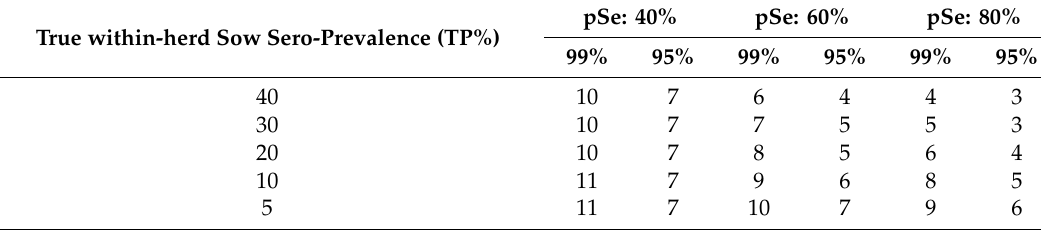
Table 4. Number of pools required ( r ) for fixed pool size ( k = 3) to provide 99% or 95% confidence to detect decreasing values of true within-herd sow prevalence (TP) assuming a pool sensitivity (pSe) of 40%, 60% and 80% and a pool specificity of 65%. True within-herd Sow Sero-Prevalence